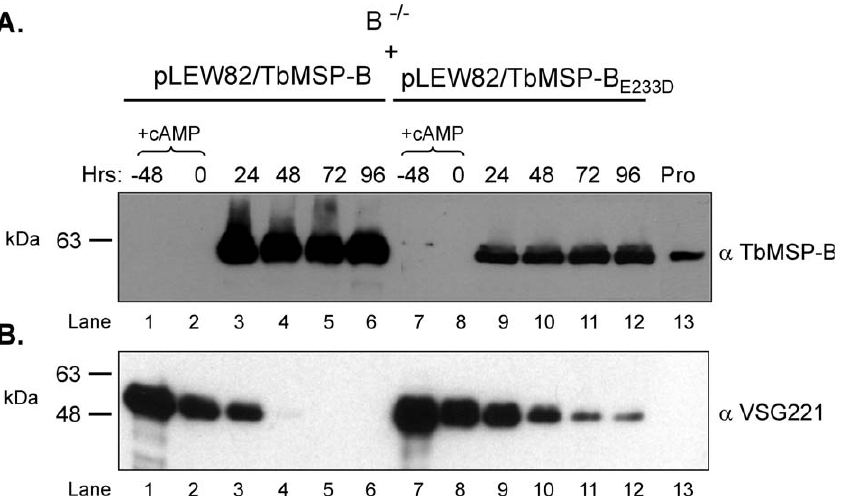
Figure 9. Complementation of B (cid:2) / (cid:2) Cells with TbMSP-B Encoded on an Integrated Plasmid BSF B (cid:2) / (cid:2) cells were stably transfected with linearized pLEW82/TbMSP-B or pLEW82/TbMSP-B E233D expression plasmid and stimulated to differentiate as previously described except that 1 l g tetracycline/ml was added at times 0 and 48 h to induce TbMSP-B or TbMSP-B E233D expression from the integrated plasmid. Extracts prepared from cells collected at the indicated times were probed in western blots with antiserum against (A) TbMSP-B ( a TbMSP-B) and (B) VSG221 ( a VSG221). The lane labeled PRO contains an extract of PRO cells grown continuously at 26 8 C in PRO medium.